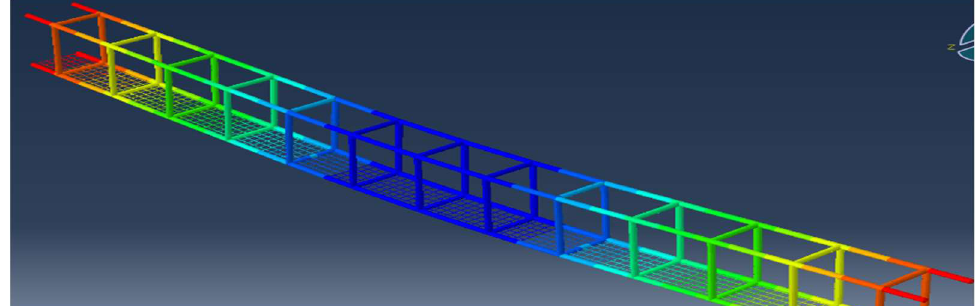
Figure 19. Displacement of Beam Reinforcement.